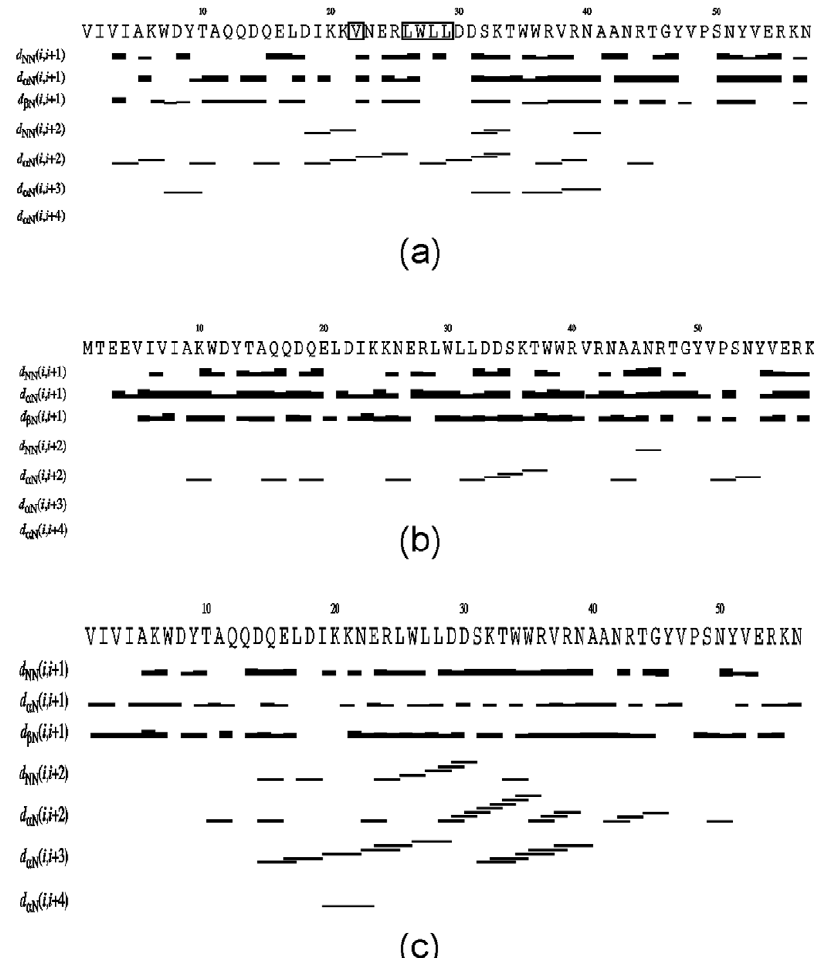
Figure 6. Characteristic NOEs defining secondary-structures. NOE connectivities identified for (a) V22-SH3 solubilized in salt-free water at pH 4.0; (b) wild-type in 50 mM sodium phosphate buffer (pH 6.5) previously published [18]; and (c) wild-type in 5 mM phosphate buffer (pH 2.0) [11]. Plots were generated by CYANA 2.1.